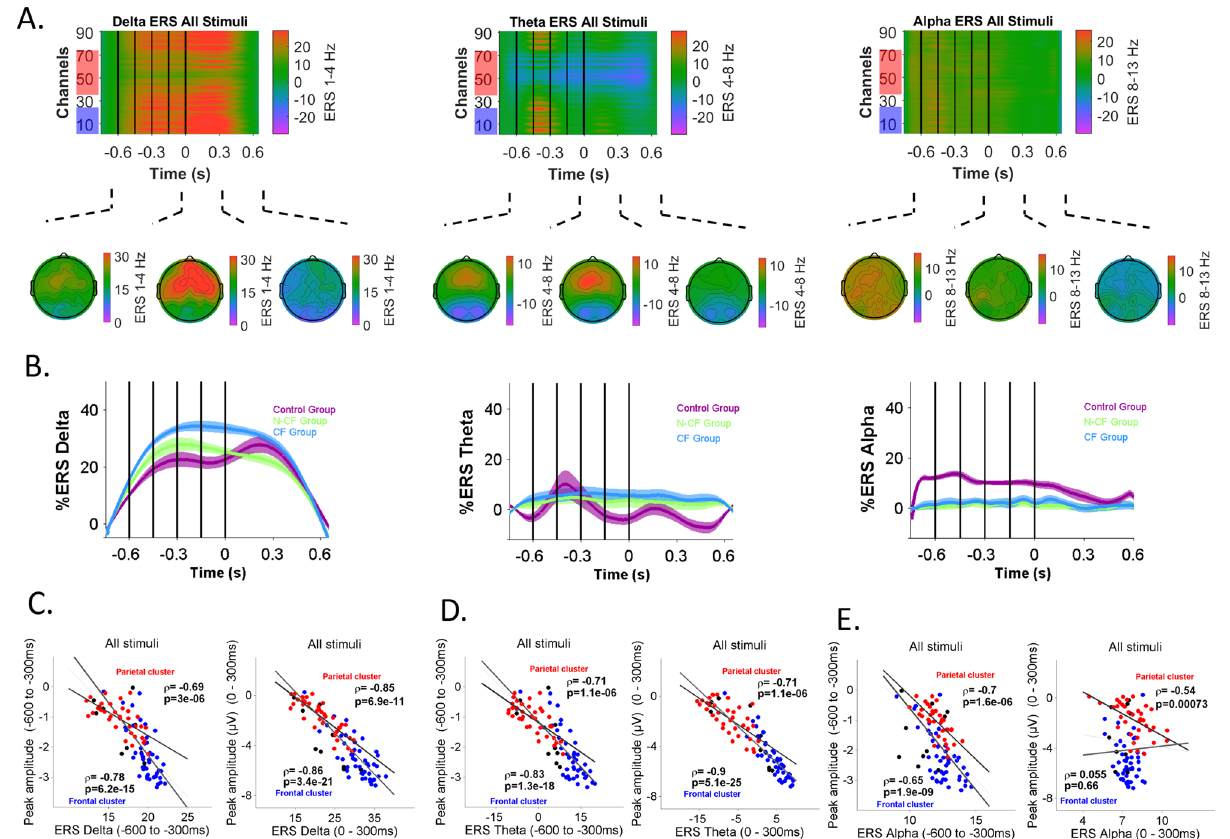
Figure 3. The temporospatial pattern of low-frequency modulation. ( A ) Relative changes in the time– frequency ERS delta (left), theta (middle) and alpha activity (right) related to the average of all stimuli for healthy subjects. Y axis display EEG channels, red box show parietal channels and blue box frontal channels. ( B ) Average of relative changes across CF (blue), N-CF (green) and the control group (purple) for all stimuli and all channels. ( C )–( E ) Correlation analysis for the frontal (blue) and parietal (red) cluster between the ERS at the frequency of interest and the two main ERP responses observed across the average of all